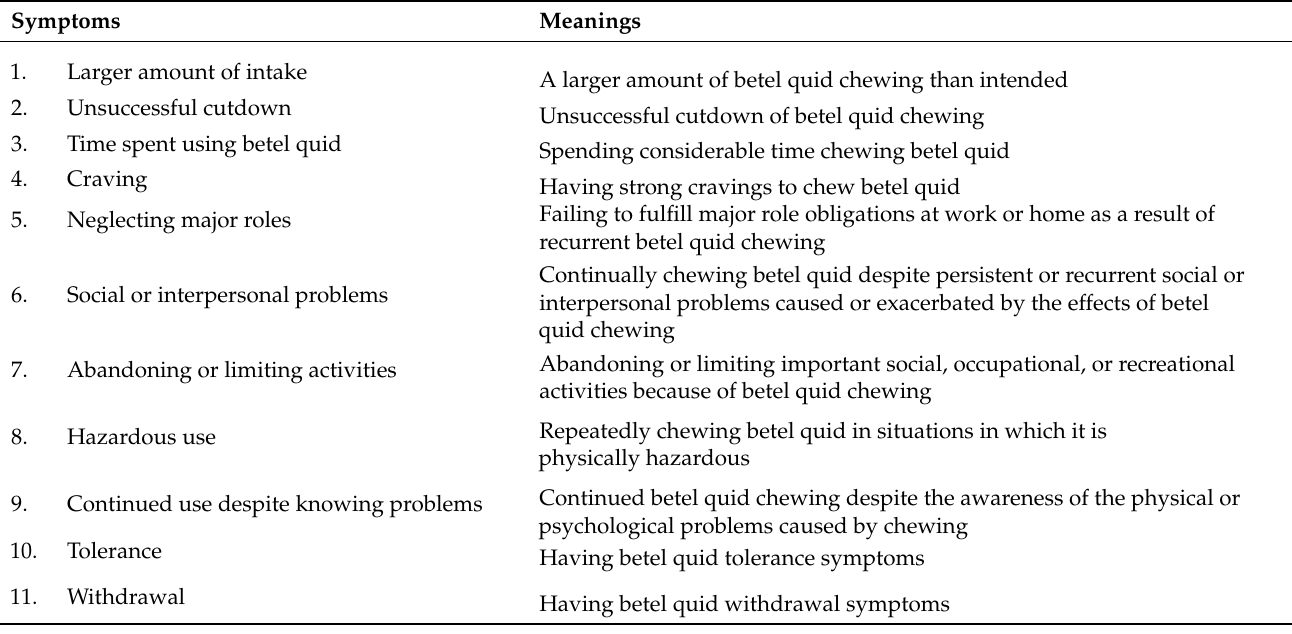
Table 1. The betel-quid-related DSM-5 symptoms and